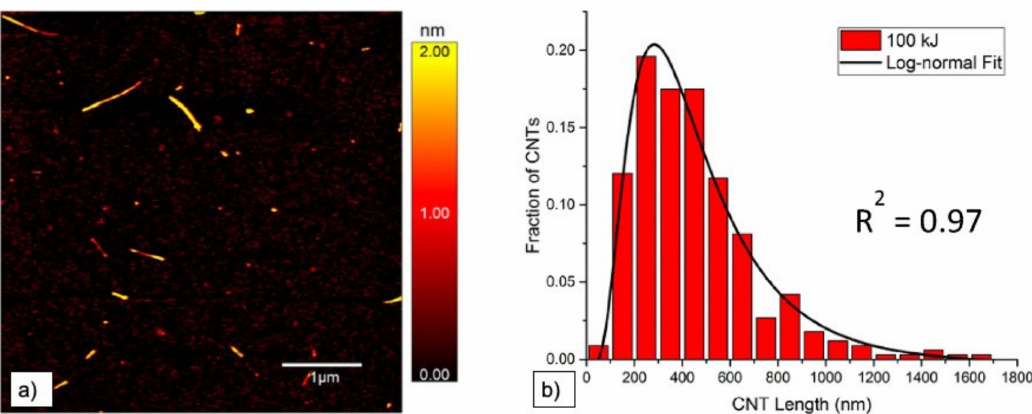
Figure 6. ( a ) Example of AFM image with visible height profile and observable length of SWCNT after sonication with a tip sonicator at 100 kJ and ( b ) the corresponding length distribution, from